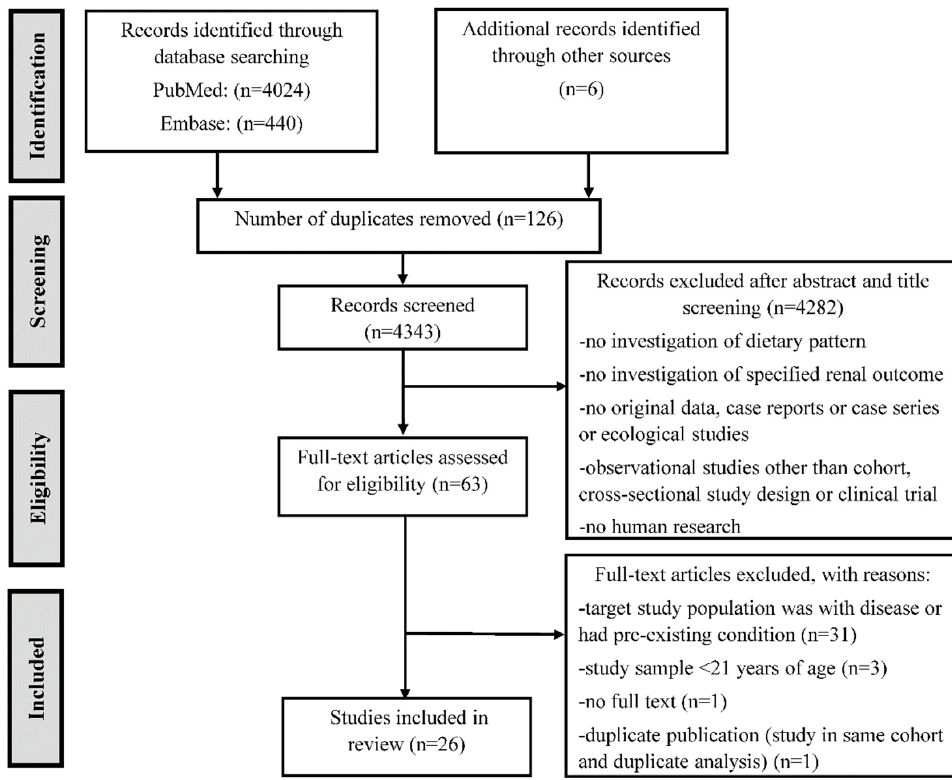
Figure 1. Flow diagram of study selection process.